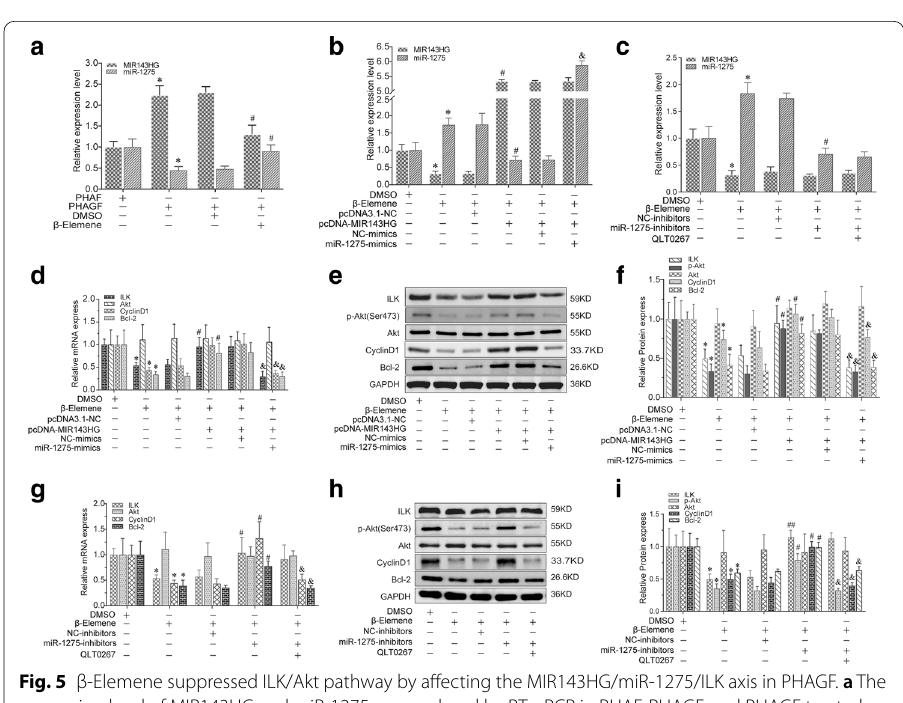
Fig. 5 β-Elemene suppressed ILK/Akt pathway by affecting the MIR143HG/miR-1275/ILK axis in PHAGF. a The expression level of MIR143HG and miR-1275 was analyzed by RT-qPCR in PHAF, PHAGF, and PHAGF treated with β-elemene. b , c RT-qPCR confirmed the transfection efficiency of pcDNA3.1-MIR143HG, miR-1275 mimics or miR-1275 inhibitors. d , g RT-qPCR was used to detect the ILK/Akt pathway-related mRNAs in PHAGF under indicated treatment. e – f , h – i Western blotting was used to detect expression of ILK/Akt pathway-related proteins in PHAGF under indicated treatment. * P < 0.05, # P < 0.05, ## P < 0.01, & P < 0.05, versus solvent control group (DMSO) or NC group (negative